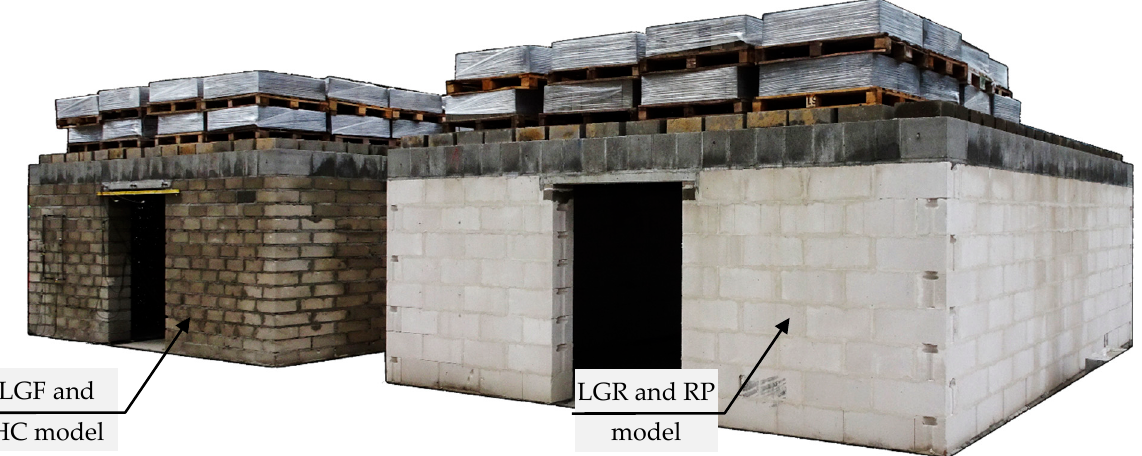
Figure 4. General view of the models: left LGR and RP model, right LGF and HC model.